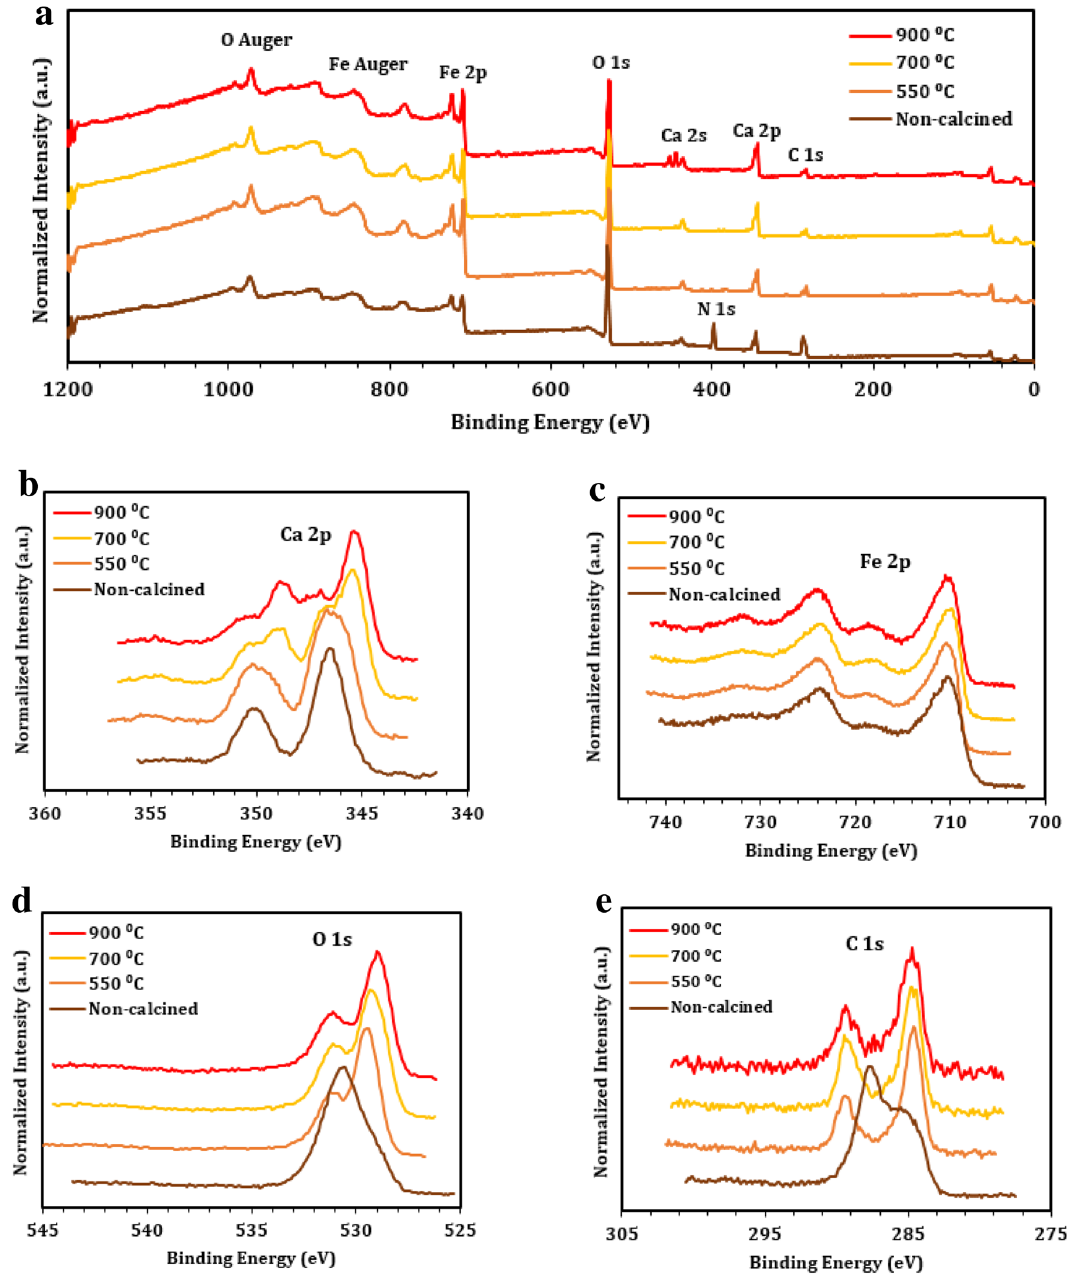
Figure 5. XPS spectra of pCFO synthesized at ϕ = 1.325 and calcined at different temperatures: ( a ) survey scan, ( b ) Ca 2p scan, ( c ) Fe 2p scan, ( d ) O 1 s scan, ( e ) C 1 s scan. Spectra have been normalized to global maxima and vertically offset for